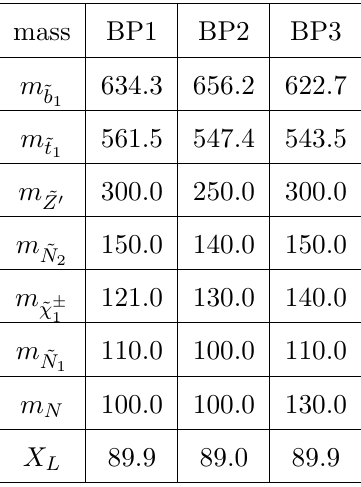
Table 1. The benchmark points for the collider study where